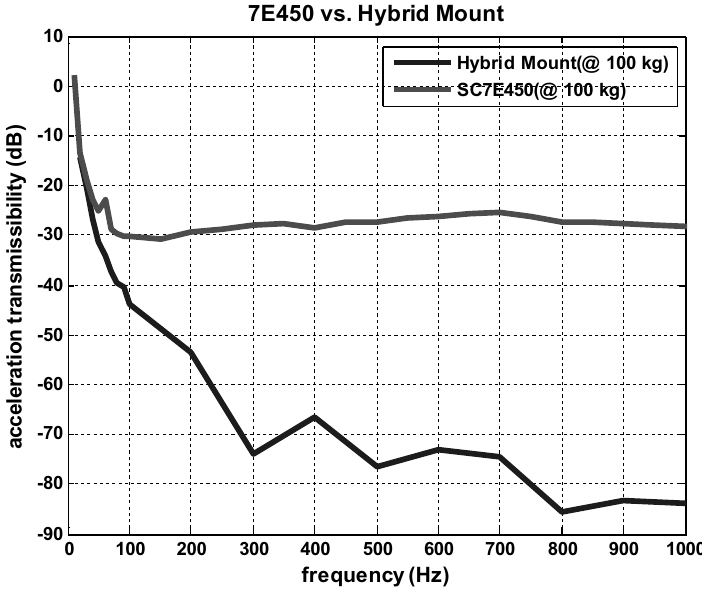
Fig. 17. Vibration transmissibility of the passive mount and hybrid